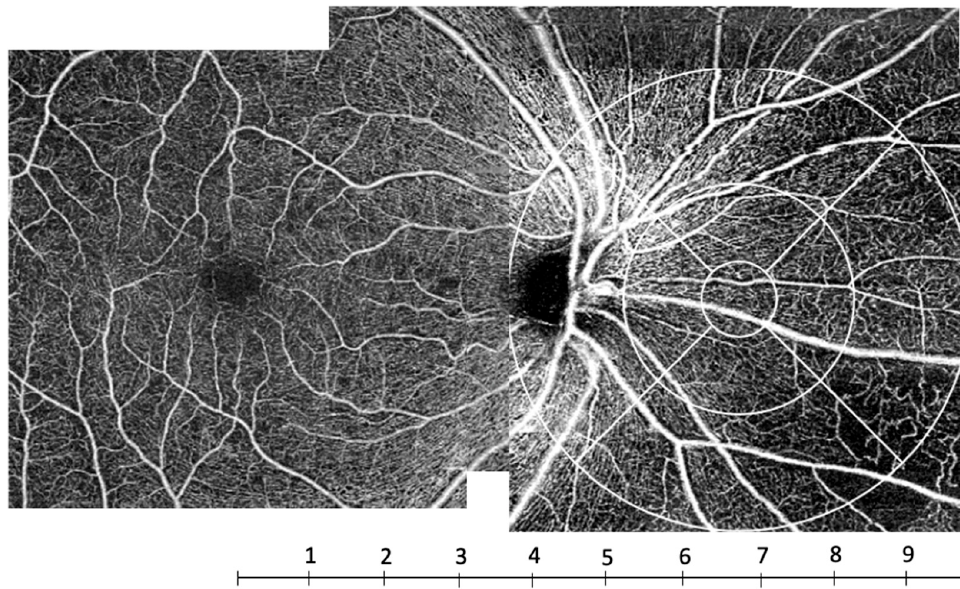
Figure 8. OCTA C-scan montage of the superficial capillary plexus (SCP) in a subject with severe non-proliferative diabetic retinopathy. The scale under the image indicates the distance to the fovea in millimeters. The capillary rarefaction predominated at a distance of about 8 mm from the fovea corresponding to zones 6, 7 and 8.